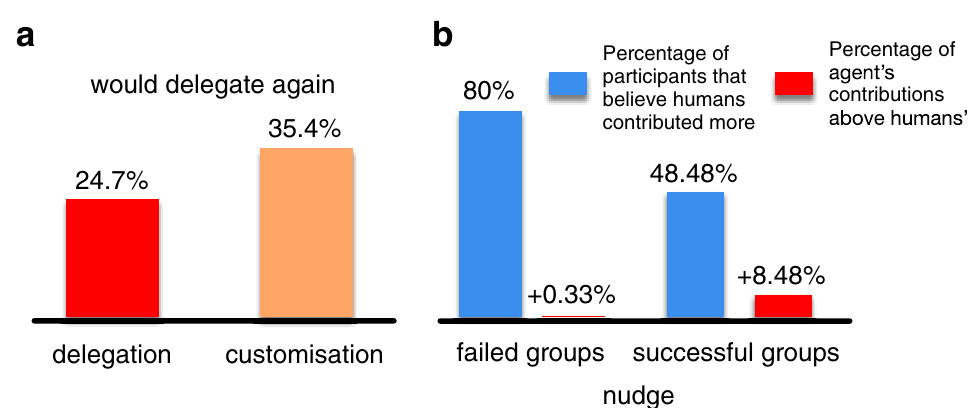
Figure 4. Willingness to delegate and trust in the artificial agents. Panel ( a ) shows the percentage of participants that would choose to delegate ( n = 89 ) or customize ( n = 48 ) an agent to play in their place if they were given the option to participate again in the experiment by themselves or to choose an agent. These results show that most participants would rather participate in the experiment by themselves, despite the higher rates of group success in comparison to the experiments with only humans. Nevertheless, there is an increase in participants that would delegate again in the customize experiment. This could indicate that allowing the customisation of artificial agents in CRD systems could be a potential relevant design feature to increase their penetration across users. Panel ( b ) shows the percentage of participants who consider that humans had made the greatest contribution effort during the nudge treatment, compared to the average contribution difference of agents with respect to humans in a group. These results show that while 80% of the human players from failed groups ( n = 15 ) believed humans contributed more during the experiment, artificial agents had marginally contributed more ( + 0.33% ). Such a result indicates a strong perception bias that attaches guilt of failure to the artificial agents. This perception decreases in participants from successful groups, where only 48.48% believe humans had put most of the effort ( n = 33 ), yet the extra effort made by the agents is only and 8.48% higher than that of the human